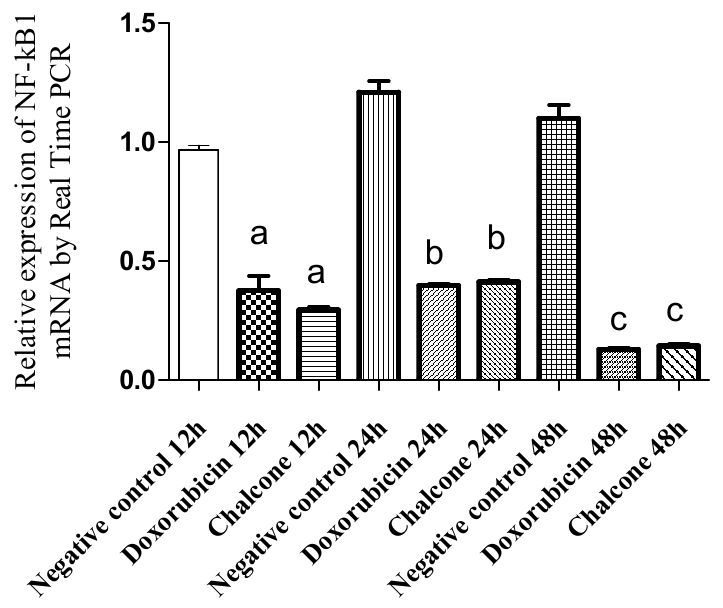
Figure 3. Relative expression of NF-kB1 mRNA in PC-3 cells treated with cardamonin, measured by qRTPCR. Doxorubicin was used as a positive control. Values are the mean ± SD ( n = 5). a = p < 0.05, ANOVA followed by the Tukey test, compared with the negative control at 12 h. b = p < 0.05, ANOVA followed by the Tukey test, compared with the negative control at 24 h. c = p < 0.05, ANOVA followed by the Tukey test, compared with the negative control at 48